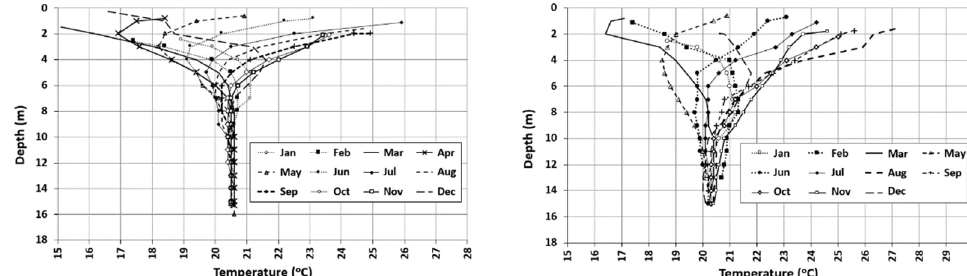
Figure 7. TDPTS for piezometer P-8 in 2011 (no arti fi cial recharge, left ) and 2020 (intensive arti fi cial recharge, right ).